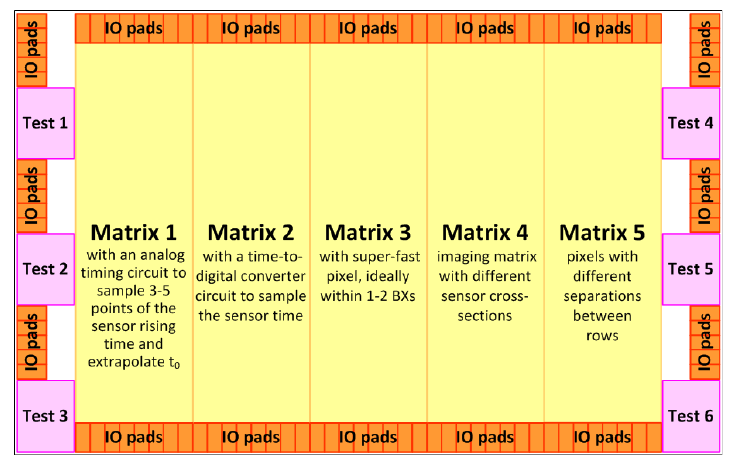
Figure 7. Diagram of the RD50-ENGRUN1 device main